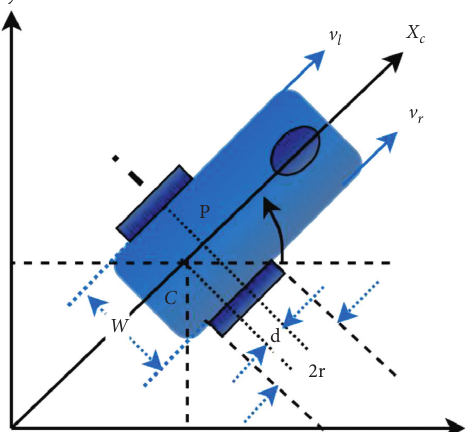
Figure 1: Kinematics model of the mobile robot. where: 2 r : the diameter of the two-wheel; W : the distance between two driving wheels; c : the mobile robot’s centre of gravity (COG) which is centred at a point; d : the distance between points P and C ; P : located at the intersection of a straight line passing through the centre of the vehicle and a line passing through the axis of the two wheels; V r : linear right wheel velocity; V l : linear left wheel velocity; V t : linear tangential velocity; W r : angular right wheel velocity; W l : angular left wheel velocity; and W t : angular tangential